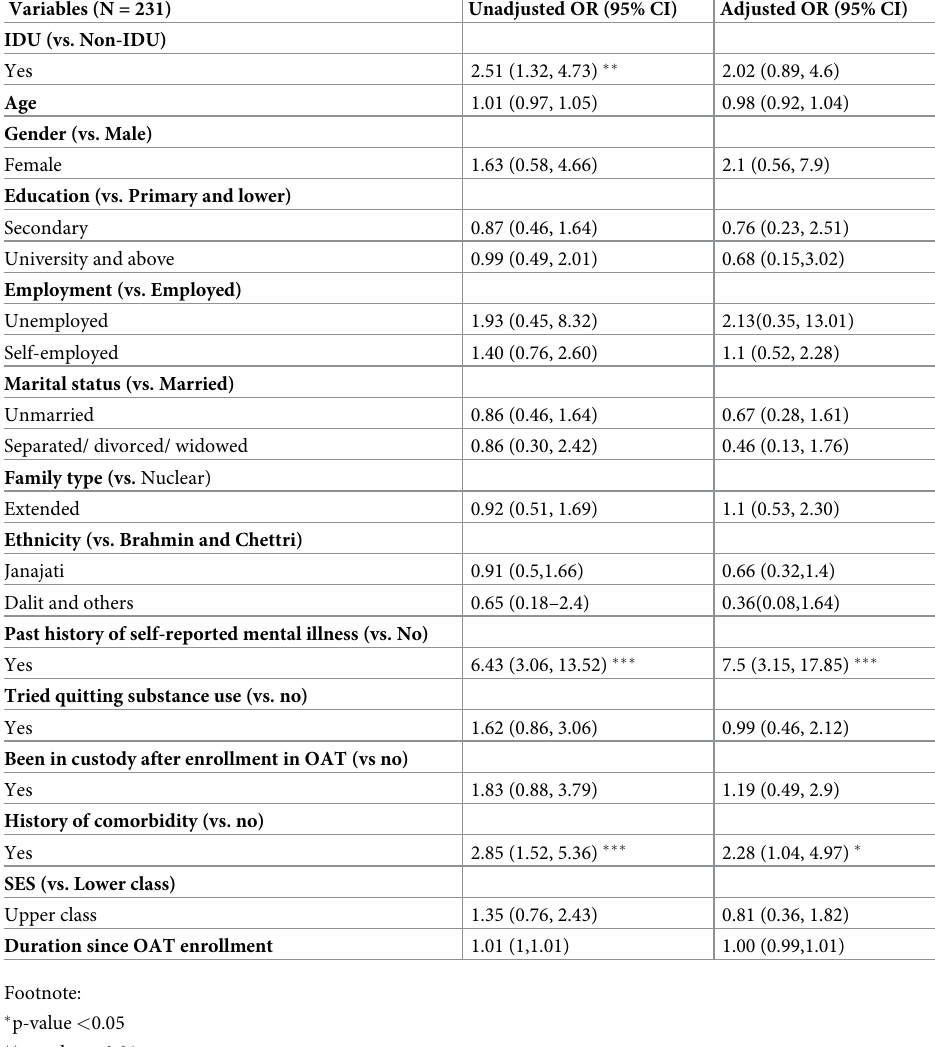
Table 4. Factors associated with Serious psychological distress